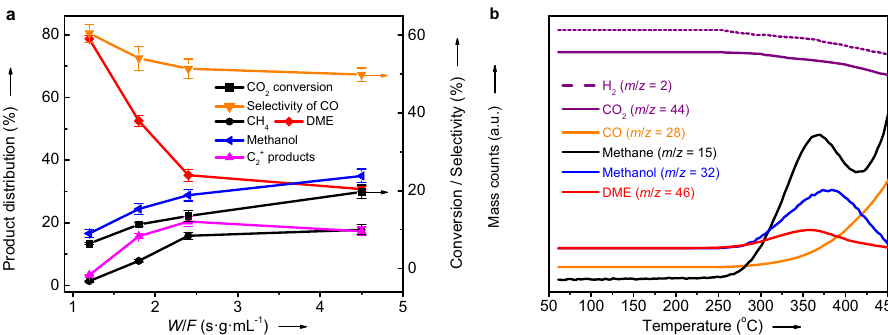
Fig. 6 Experimental results con fi rming DME as the primary product. a Effect of the contact time on the catalytic behavior of the hydrogenation of CO 2 over GaN-26.6 at 360 °C (The contact time is expressed as the catalyst weight ( W ) divided by the fl ow rate of the feed gases ( F ). The error bar representing the relative deviation is within 5%). b Temperature-programmed surface reaction pro fi les of the hydrogenation of CO 2 over GaN-26.6 under the conditions of P = 2.0 MPa and H 2 /CO 2 = 2 ( m / z : mass-to-charge